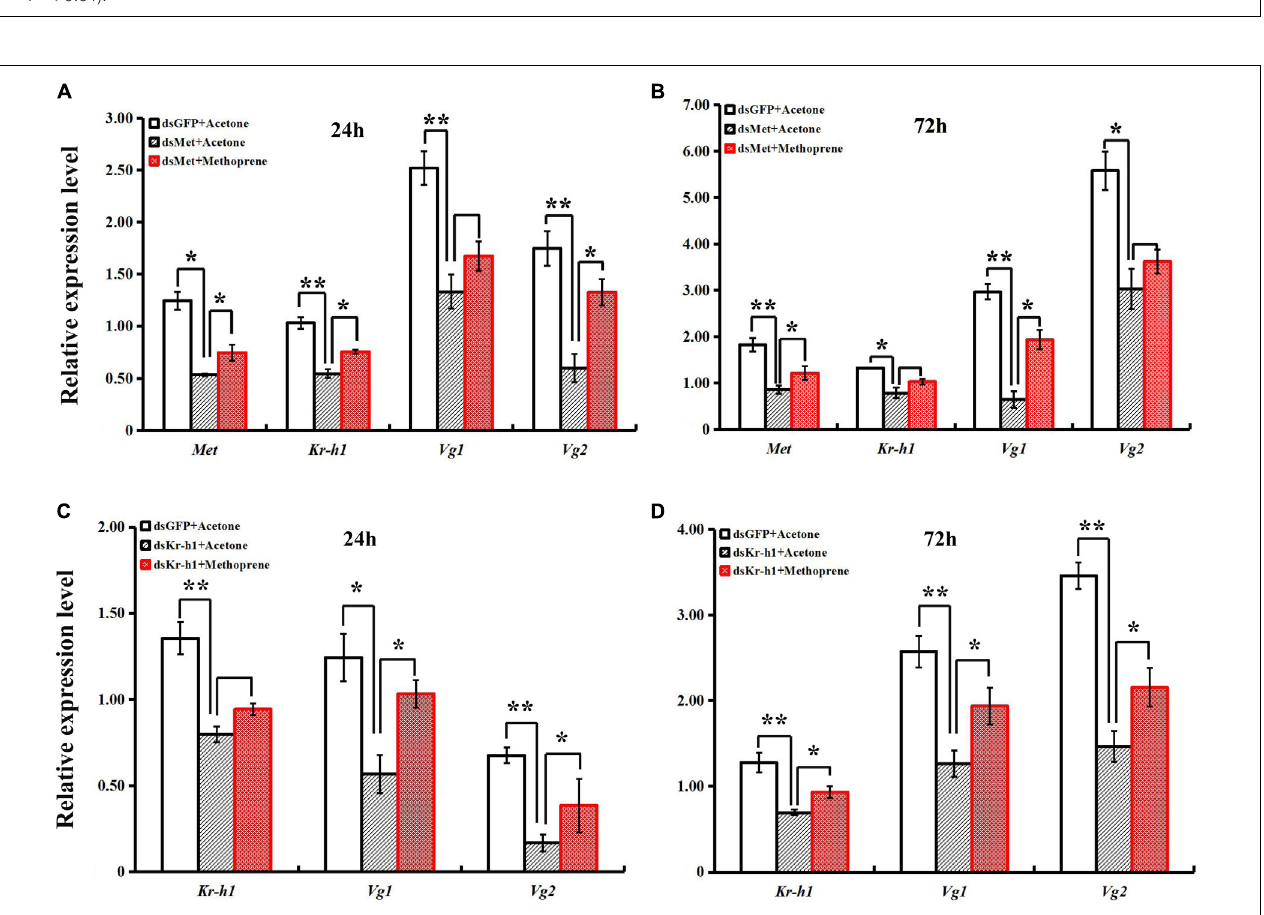
FIGURE 6 | Effects of methoprene treatment on expressions of JH signaling and Vg genes from Met- and Kr-h1 -depleted female adults. Methoprene was applied 2 h after dsRNA injection. Transcript levels of BdMet , BdKr-h1 , BdVg1 , and BdVg2 24 h (A) and 72 h (B) after dsMet injection + methoprene with two controls (i.e., dsGFP + Acetone and dsMet + Acetone). Transcript levels of BdKr-h1 , BdVg1 , and BdVg2 24 h (C) and 72 h (D) after dsKr-h1 injection + methoprene with two controls (i.e., dsGFP + Acetone and dsKr-h1 + Acetone). Three replicates were conducted, with the data presented as mean ± SE. Significant differences between treatment and control are indicated with asterisks ( ∗ P < 0.05; ∗∗ P < 0.01).